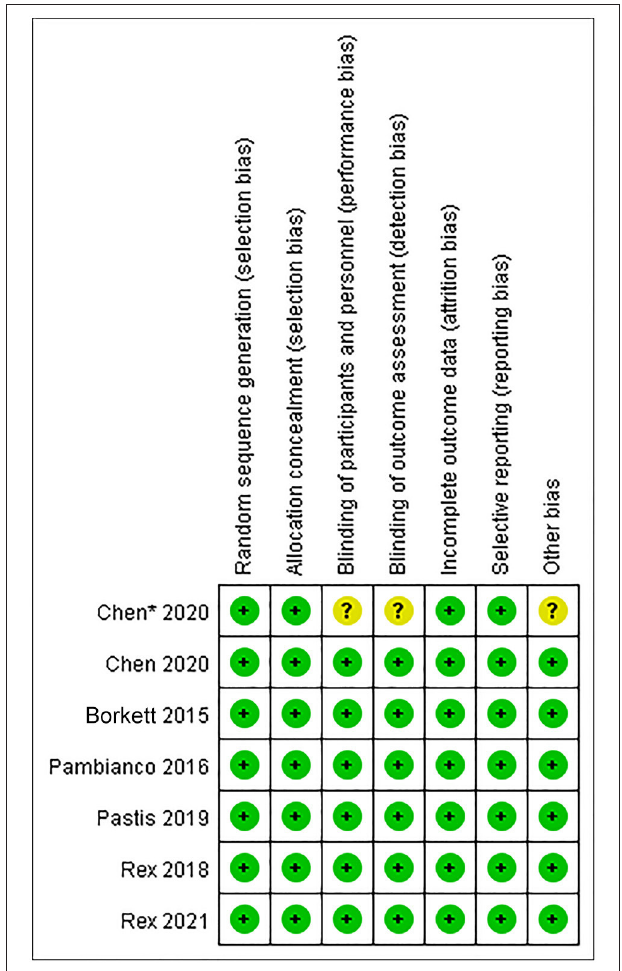
FIGURE 3 | The risk of bias summary of included